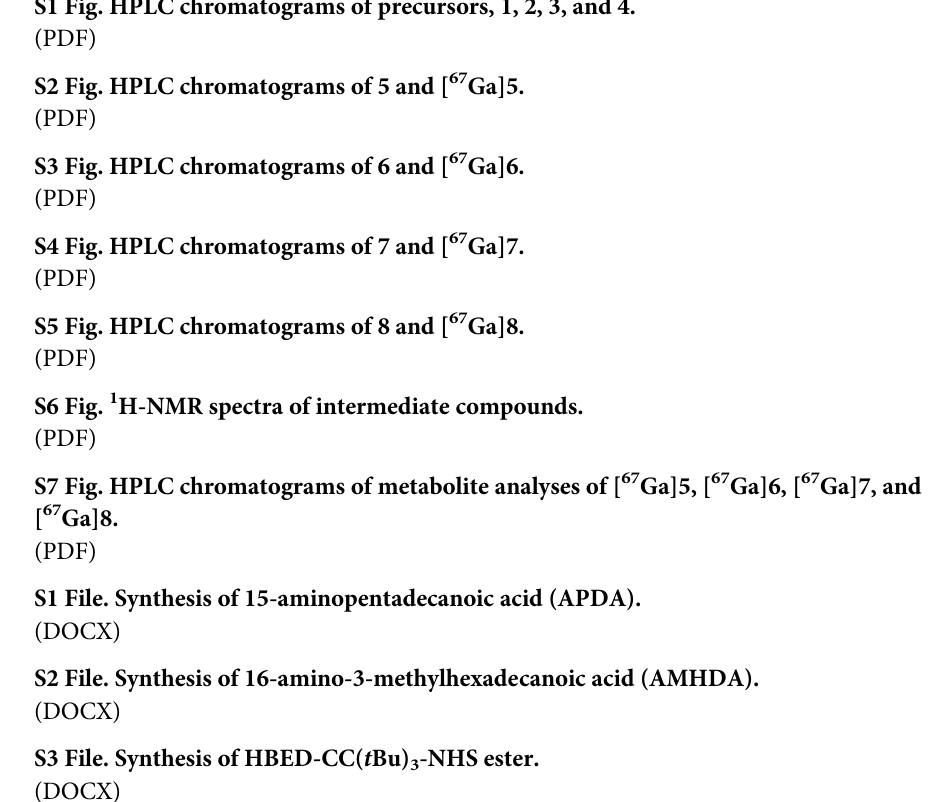
S1 Fig. HPLC chromatograms of precursors, 1, 2, 3, and 4.